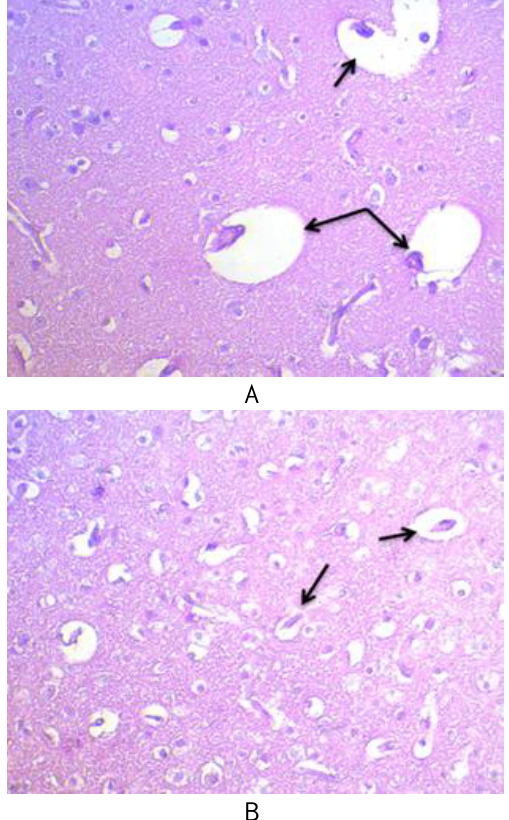
Figure,10: Brain shows neuronal degeneration, hypertrophy, oedema (black arrows A&B) and lymphocytic infiltration. (H&E